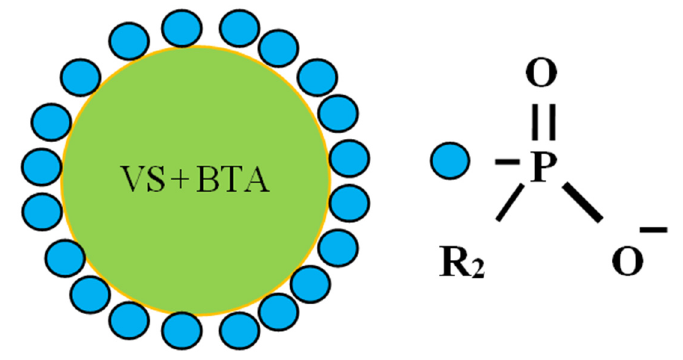
Figure 2. Inhibitor dispersion micelle structure. From the data presented in Figure 1 and Table 2, it can be seen that in the